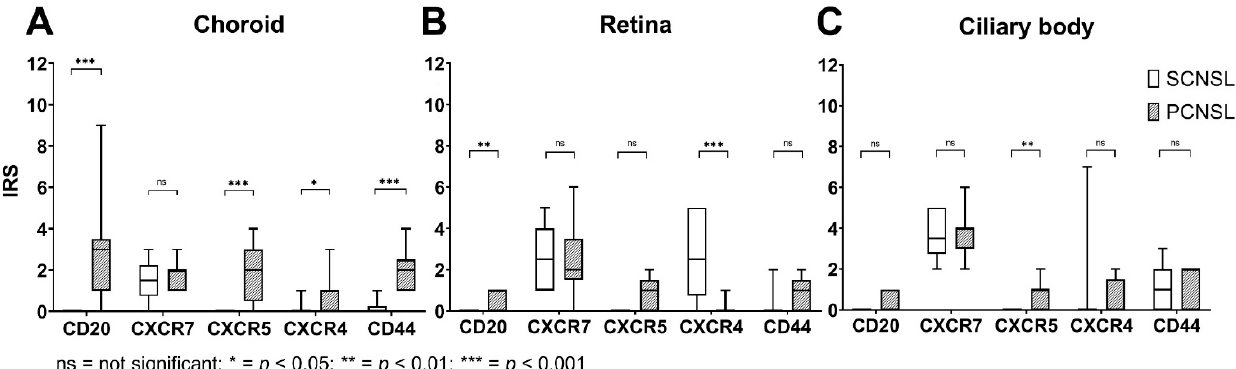
Figure 5. Box Plots of IRS values of CD20, CXCR7, CXCR5, CXCR4, and CD44 of the choroid, the retina, and the ciliary body in the PCNSL vs. SCNSL group. ( A ) Box plots of IRS values in the choroid of the PCNSL vs. SCNSL group. The IRS was significantly higher for CD20 (marked with asteriks *** p < 0.001), CXCR5 (marked with asterisks *** p < 0.001), CXCR4 (marked with asterisks * p < 0.05) and CD44 (marked with asterisks *** p < 0.001) in the PCNSL compared to the SCNSL group. ( B ) Box plots of IRS values in the retina of the PCNSL vs. SCNSL group. The IRS was significantly higher for CD20 (marked with asterisks ** p < 0.01) and CXCR4 (marked with asterisks *** p < 0.001) in the PCNSL compared to the SCNSL group. ( C ) Box plots of IRS values in the ciliary body of the PCNSL vs. SCNSL group. The IRS was significantly higher for CXCR5 (marked with asterisks ** p -value < 0.01) in the PCNSL compared to the SCNSL group. ns = not